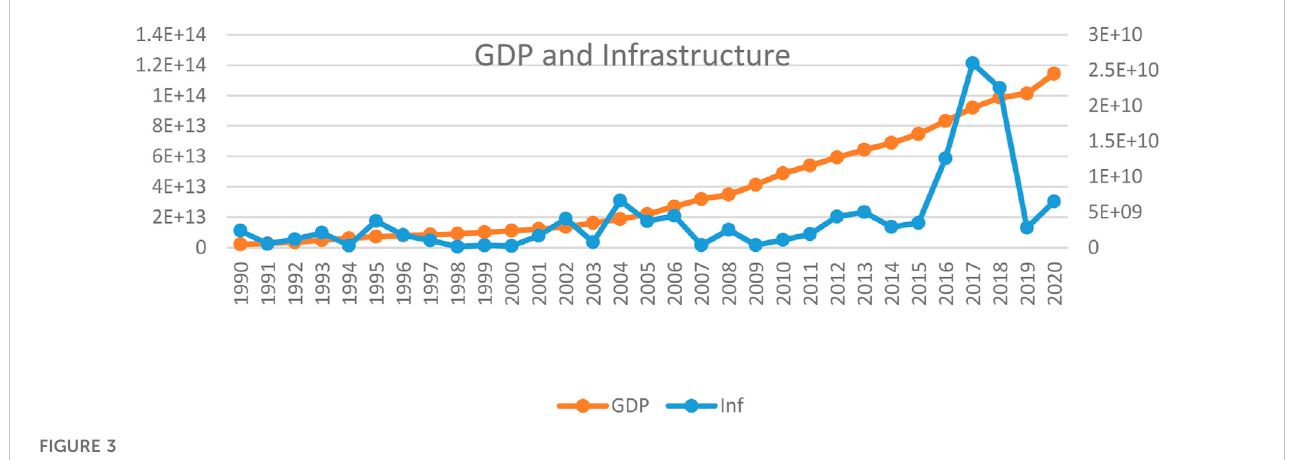
FIGURE 3 Gdp and